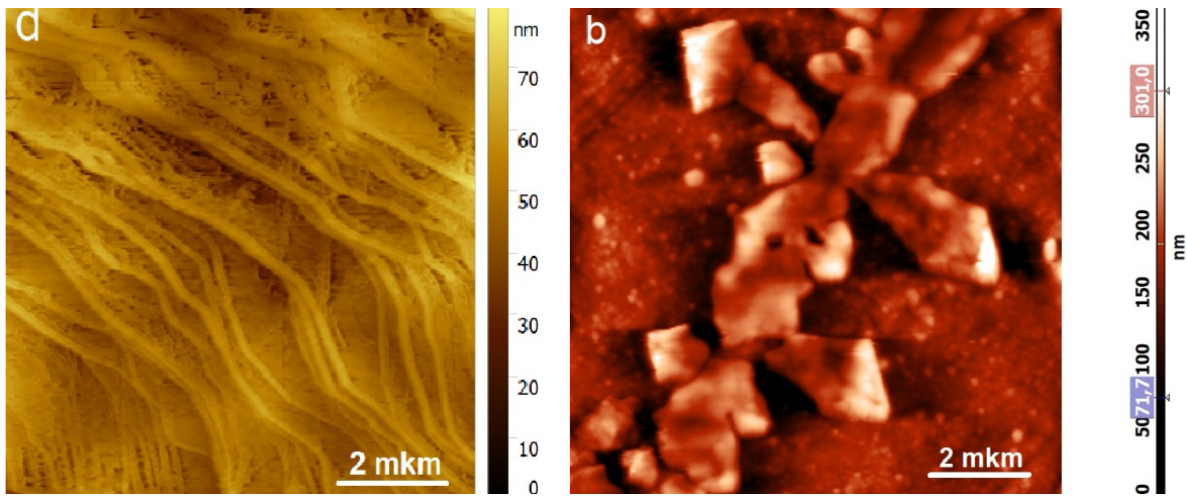
concentrations and ultrathin layers of DPT-nAu composite, gold NPs are clearly visible on the mica surface, which are surrounded by a ligand DPT shell (Figure 3a). The layers consist of gold NPs immersed in the DPT matrix. The thickness of the layer is negligible as evidenced by the presence of small pores. The average NP size is 50 nm and the height is less than 2 nm which results in the aspect ratio of 0.04.